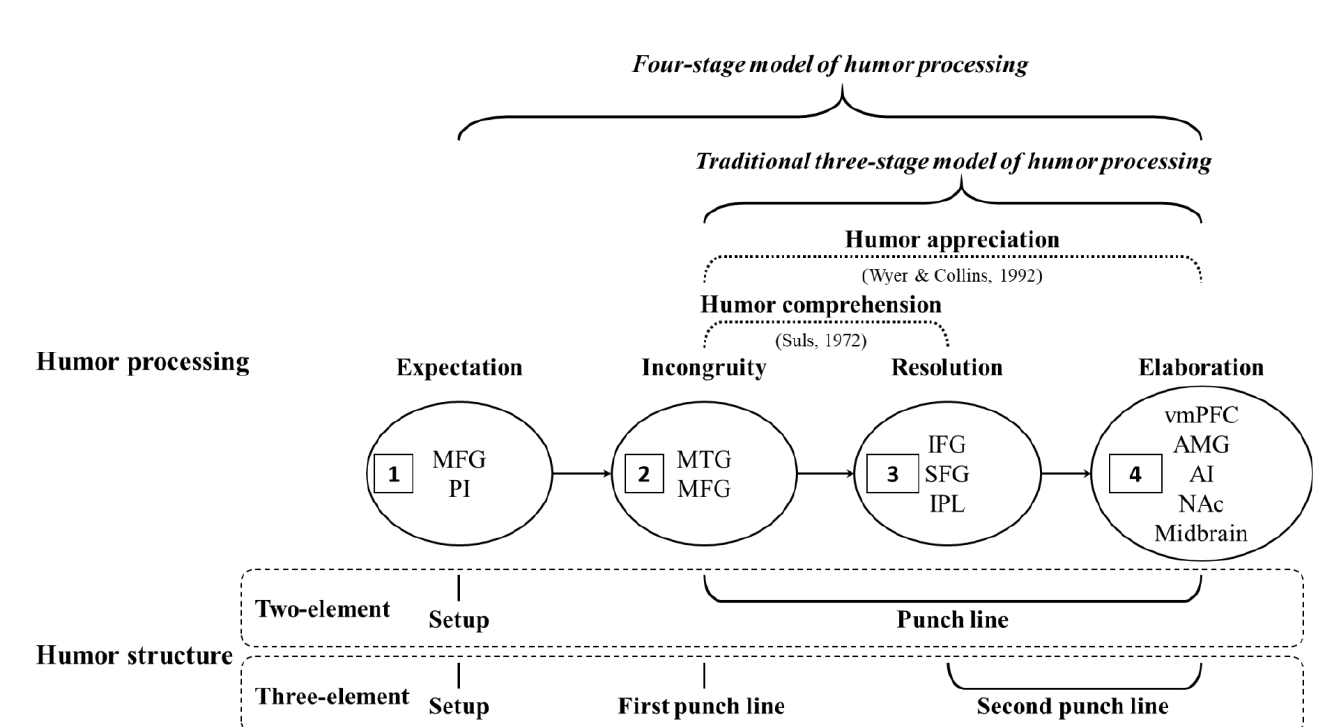
Figure 6. The four-stage model of humor processing. Humor processing and humor structure correspondence diagram. Four stages of the neural circuit underlying humor processing: expectation, incongruity, resolution, and elaboration. Figure 6 was expanded by the three-stage brain neurological process of humor comprehension and appreciation [3]. Note: MFG (in expectation stage) = middle frontal gyrus; PI = posterior insula; MTG = middle temporal gyrus; MFG (in incongruity stage) = medial frontal gyrus; IFG = inferior frontal gyrus; SFG = superior frontal gyrus; IPL = inferior parietal lobule; vmPFC = ventromedial prefrontal gyrus; AMG = amygdala; AI = anterior insula; NAc = nucleus accumbens.